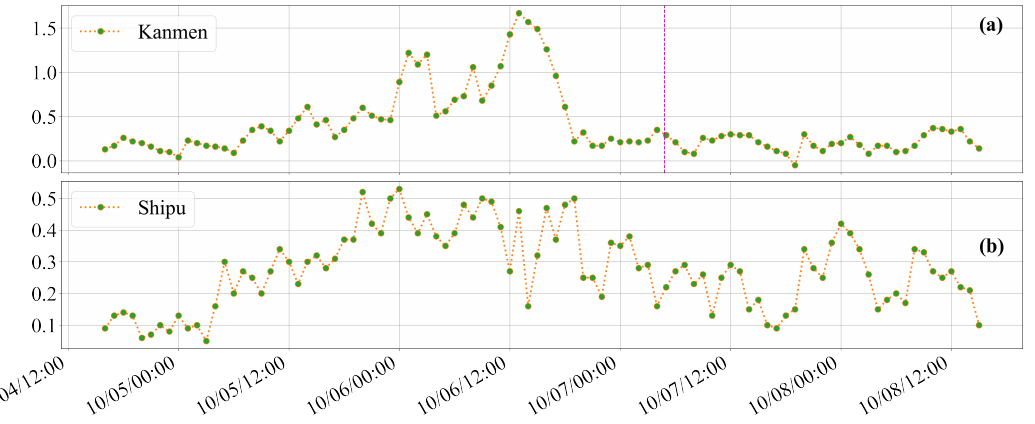
Figure 5. De-tided SLAs at ( a ) Kanmen and ( b ) Shipu tide gauge stations. The magenta dotted line indicates the time of the Jason-2 satellite passing (04:50 UTC on 7 October 2013). The landing time of 1323Fitow was 05:15 on 6